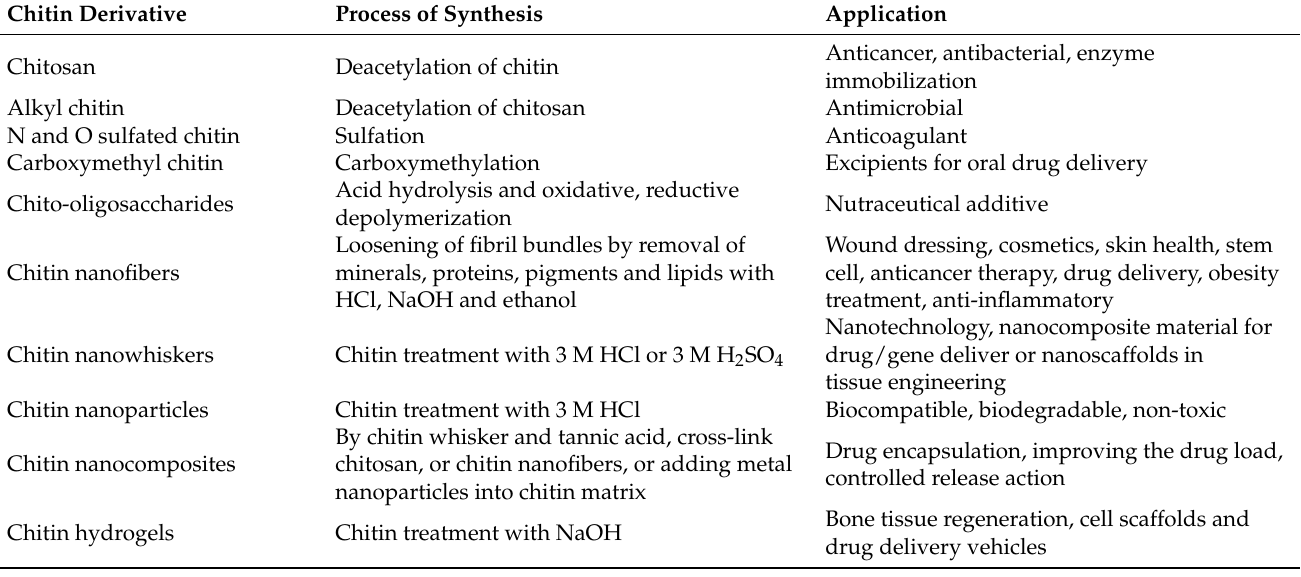
Table 2. Biomedical applications of chitin and its derivatives. Adapted from Singh et al.